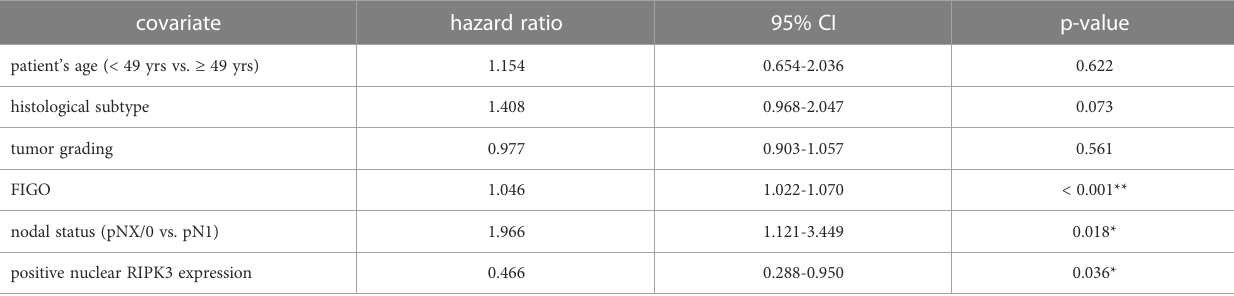
TABLE 4 Multivariate Cox regression analysis of cervical cancer patients ( n = 250) and their clinical and pathological characteristics including nuclear RIPK3 expression regarding PFS. covariate hazard ratio